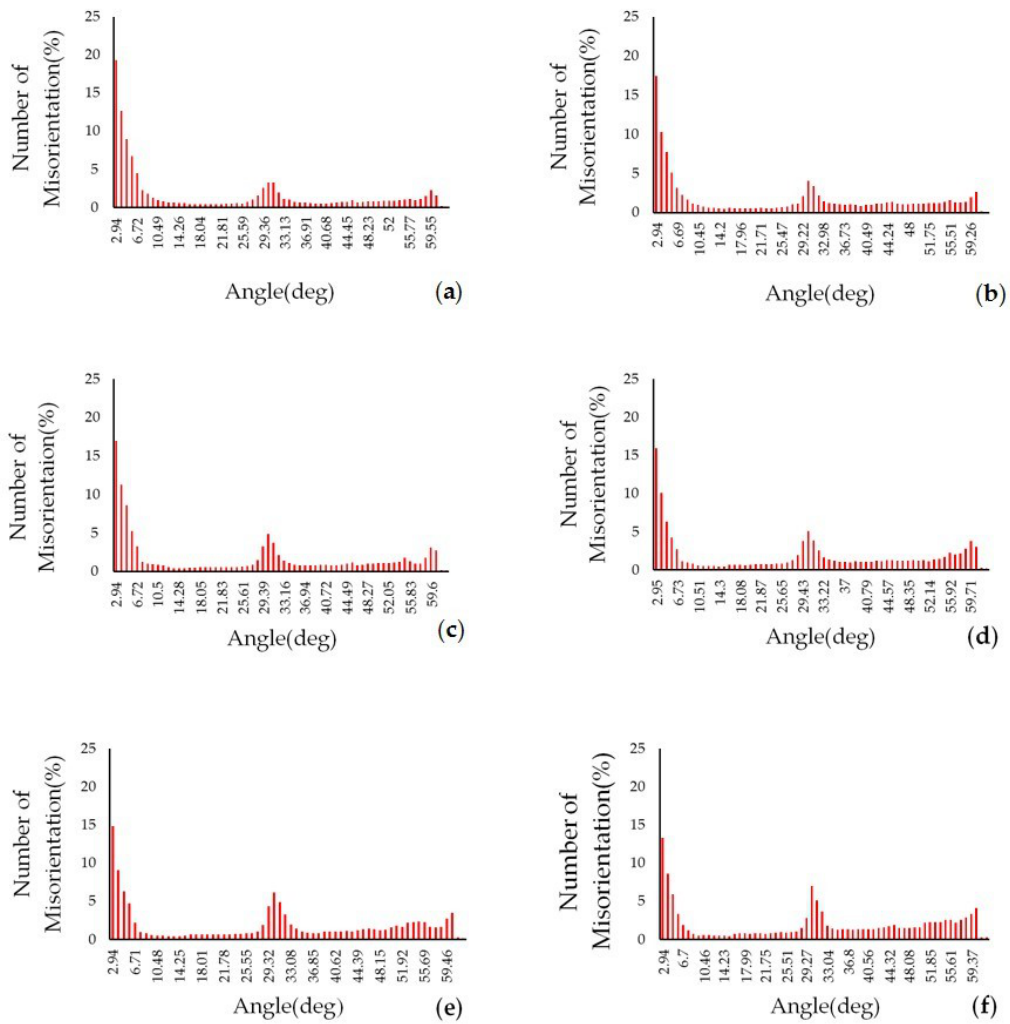
Figure 7. Misorientation distribution of steel strips deformed at ( a ) RT = 790 °C, symmetric rolling, ( b ) RT = 790 °C, asymmetric rolling, ( c ) RT = 830 °C, symmetric rolling, ( d ) RT = 830 °C, asymmetric rolling, ( e ) RT = 870 °C, symmetric rolling, ( f ) RT = 870 °C, Asymmetric rolling.